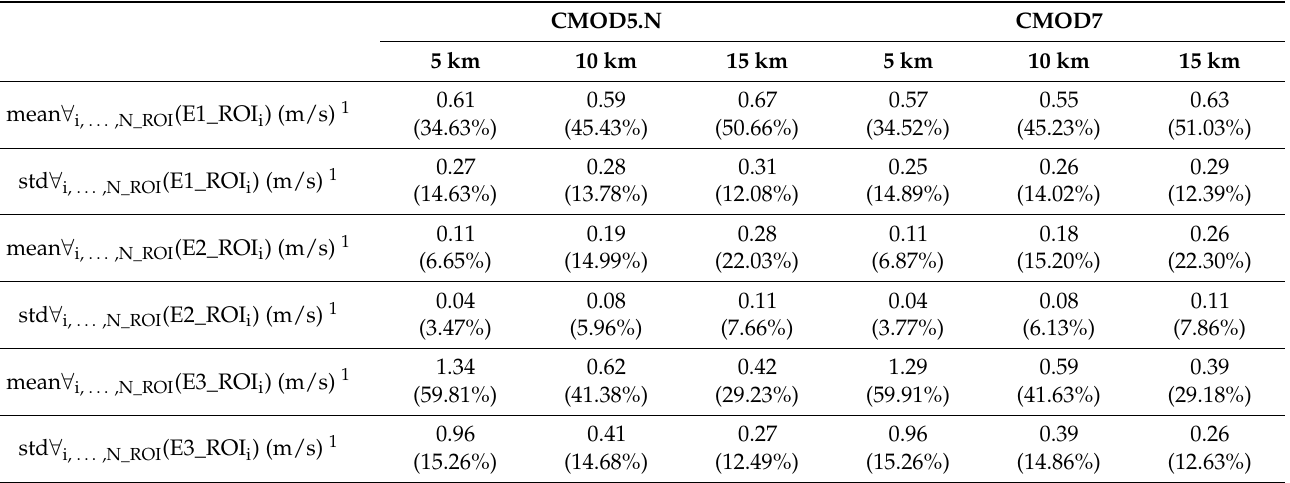
Table 3. Statistics (in (m/s)) and ratio (in (%)) about the contribution, due to the true state ( σ 0 , θ , ϕ ) and a single uncertainty among the ones regarding the NRCS ( ∆ σ 0 ) (E1), the incidence angle ( ∆ θ ) (E2) and the MS LG-Mod SSW (relative) direction ( ∆ ϕ ) (E3), to the total SAR SSW speed uncertainty (m/s) for all ROIs, at various dimensions and for two different applied GMFs. CMOD5.N CMOD7 5 km 10 km 15 km 5